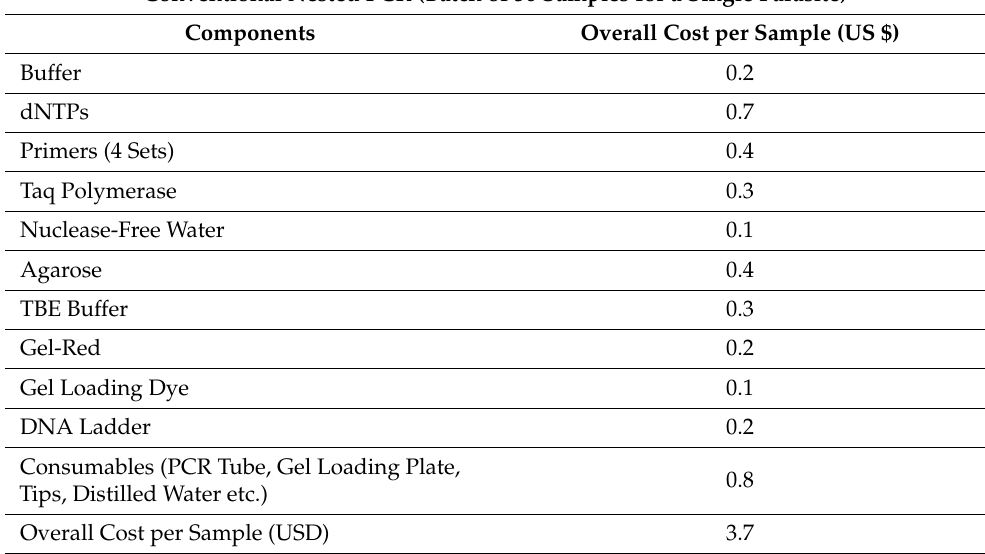
Table 4. Cost distribution and comparison among conventional nested, Sybr green (this method) and Taqman probe-based PCR